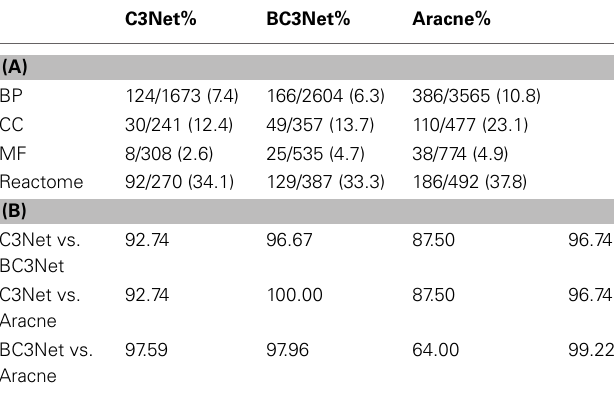
Table 2 | (A) Functional enrichment using a GPEA for the C3Net, BC3Net, and Aracne GRN. Shown are the numbers of significant terms/number of total terms, and the percentage of significant terms. (B) Overlap percentage (%) of significant terms in the GPEA between the C3Net, BC3Net and Aracne gene regulatory